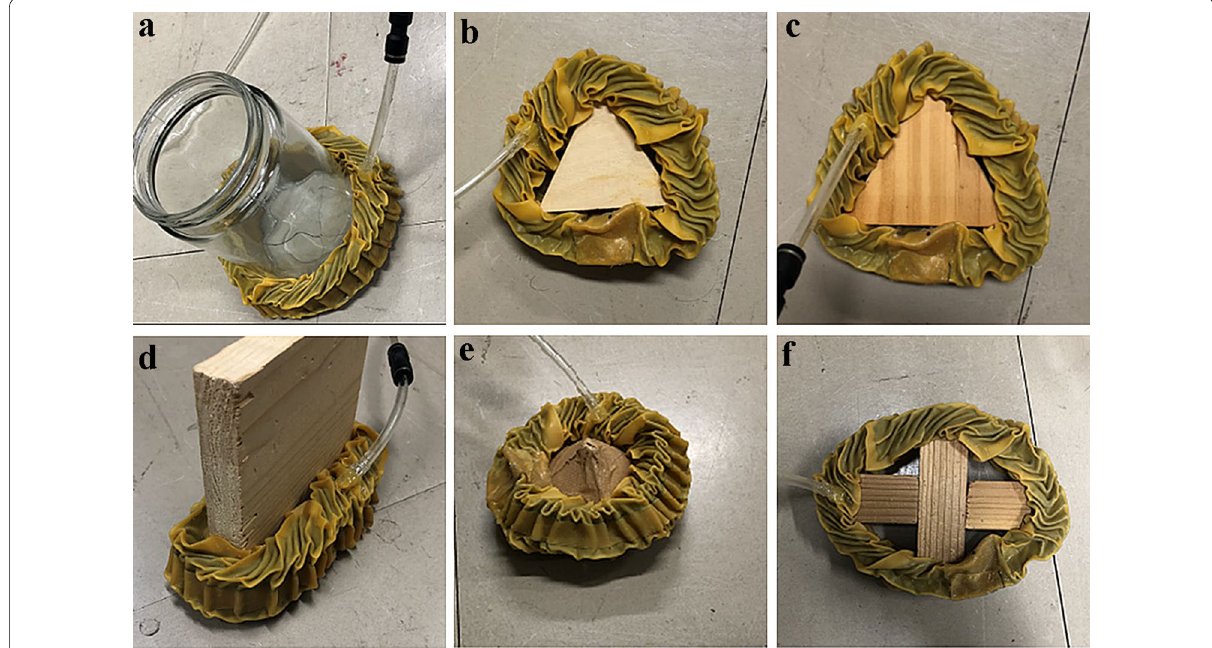
Fig. 9 Performance of gripping objects of various shapes: a a bottle; b a small triangular prism; c a large triangular prism; d a plate; e a cone; f a cross-shaped prism. The gripper wrapped it around the bottle, plate, and cone without any gaps. The gripper wrapped it around triangular prisms. However, larger gaps were observed for the smaller triangular prism. For a cone, the gripper twists and wraps around the slope. For a cross-shaped prism, gaps appeared in concave areas